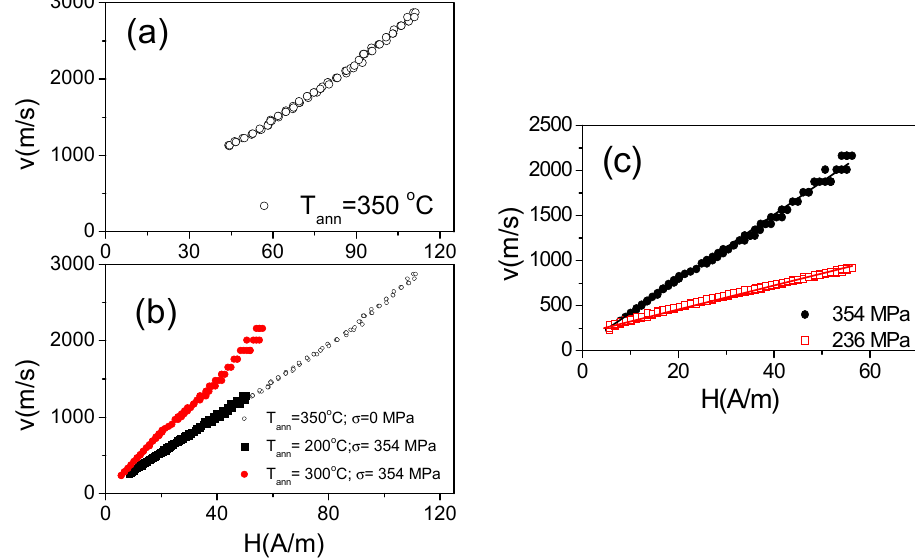
Figure 12. v ( H ) dependencies measured for the Fe 3.6 Co 69.2 Ni 1 B 12.5 Si 11 Mo 1.5 C 1.2 samples annealed at T ann = 350 °C ( a ) for the sample annealed at σ a = 0 MPa and σ a = 354 MPa for different T ann ( b ) and at T ann = 350 °C for different applied stress ( c ).